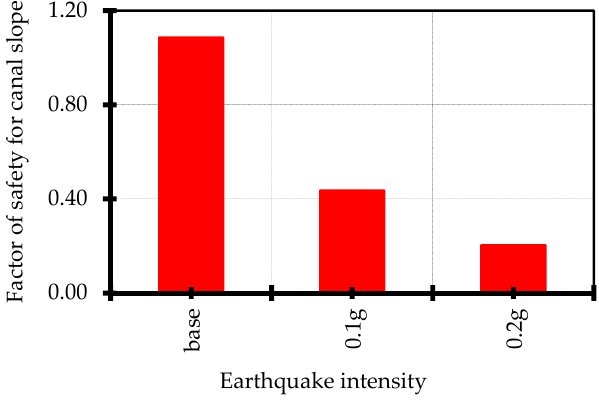
Figure 19. Canal factor of safety for earthquake intensity by 0.1 g and 0.2 g.